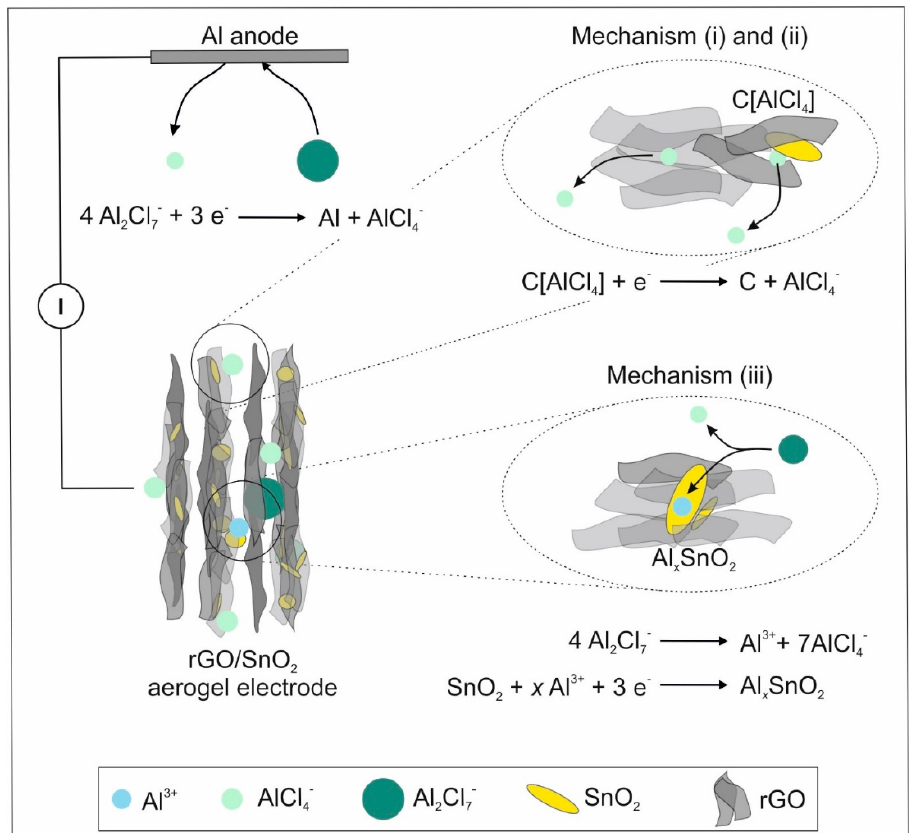
Figure 7. A schematic representation of the rGO/SnO 2 aerogel electrode in a half-cell configuration (left), where the three different energy storage mechanisms occurring at the cathode are presented with the corresponding simplified chemical reactions (right).